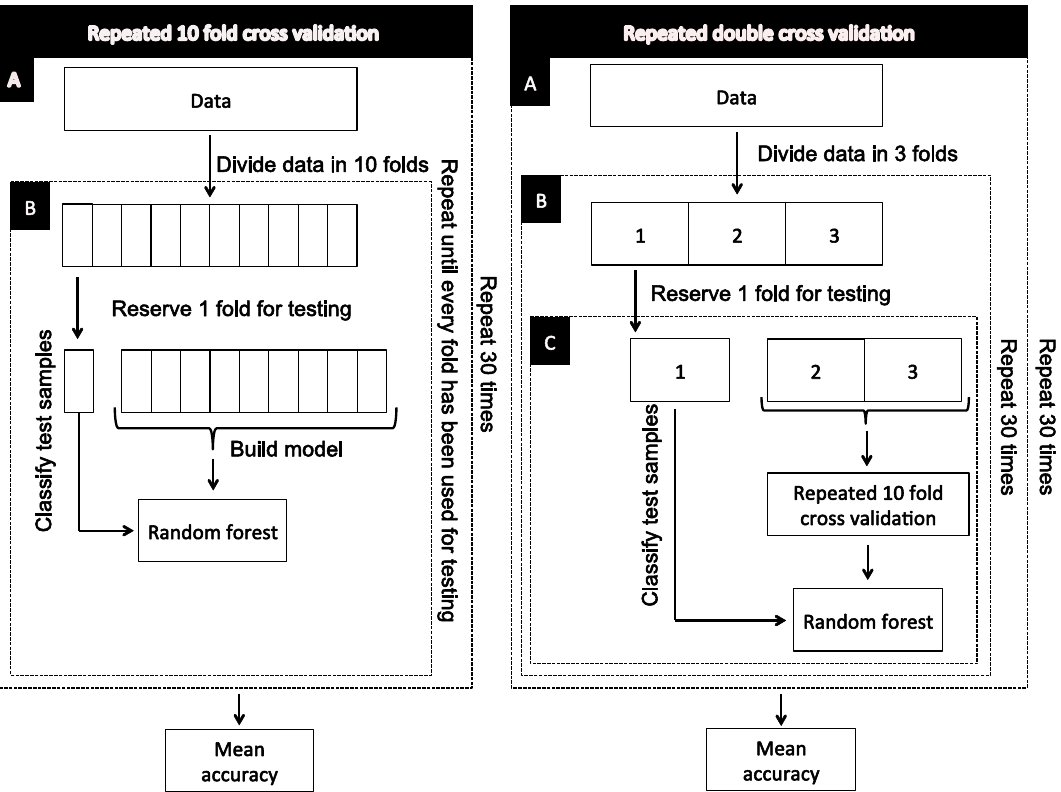
Fig 1. The pipeline of the validation techniques known as repeated 10 fold cross validation and repeated double cross validation. A Monte-Carlo variation of each technique is achieved by randomising the labels of the testing